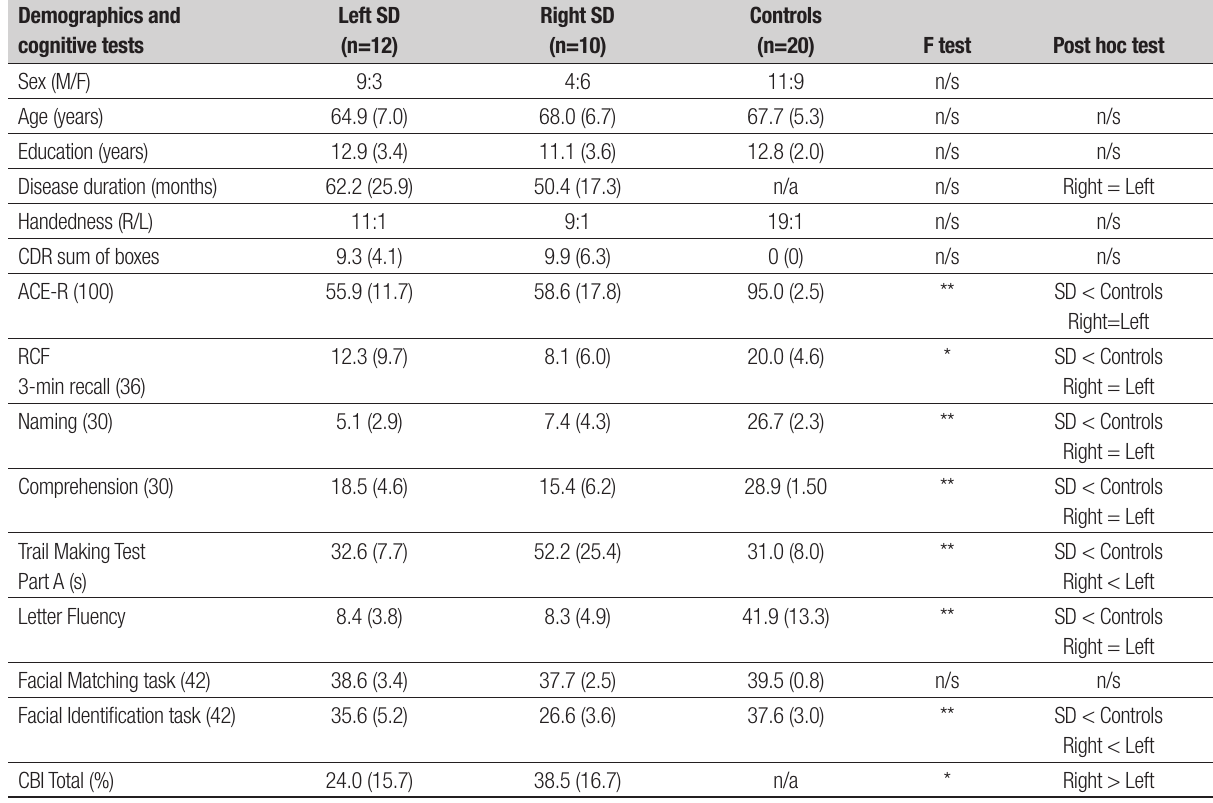
Table 1. Demographic and clinical characteristics of study cohorts (standard deviations in brackets). a,b Demographics